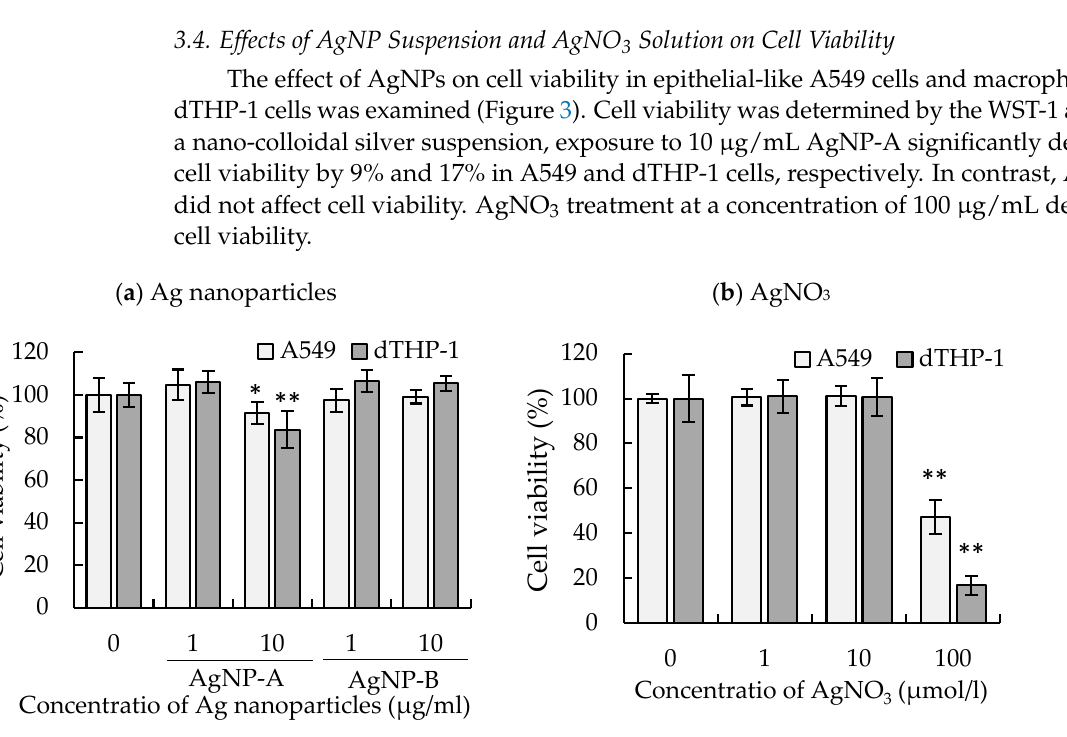
Table 2. Released silver ion concentratio from silver nanoparticles. DMEM Acidic Condition 1 with 10% FBS Rereased Ag 2+ AgNP-A 22.2